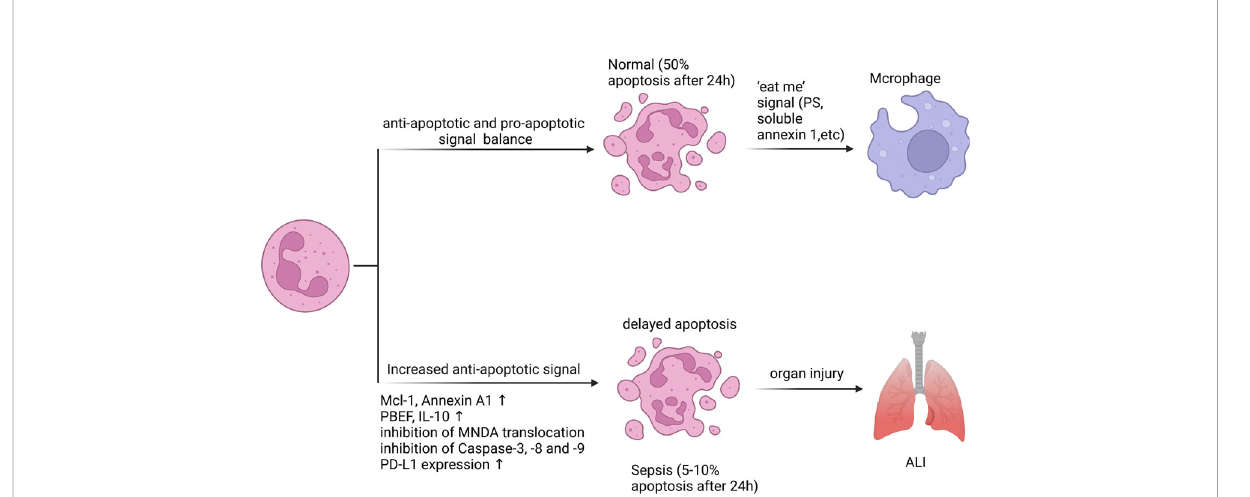
FIGURE 2 Neutrophil apoptosis is inhibited in sepsis. Apoptosis is essential for regulating the lifespan of neutrophils. In sepsis, the execution of the neutrophil death program is delayed by various stimuli. Inhibition of neutrophil apoptosis or reduction of macrophage uptake of apoptotic neutrophils can exacerbate injury to tissues or organs. 50% of resting neutrophils exhibited apoptotic morphological changes after 24 hours, while the corresponding percentage for septic neutrophils was only 5 - 10%. A variety of anti-apoptotic signals produced during sepsis include preservation of Mcl-1 and Annexin A1, release of PBEF, IL-10, inhibition of MNDA translocation from nucleus to cytoplasm, inhibition of Caspase-3, -8 and -9 activation, and increased PD-L1